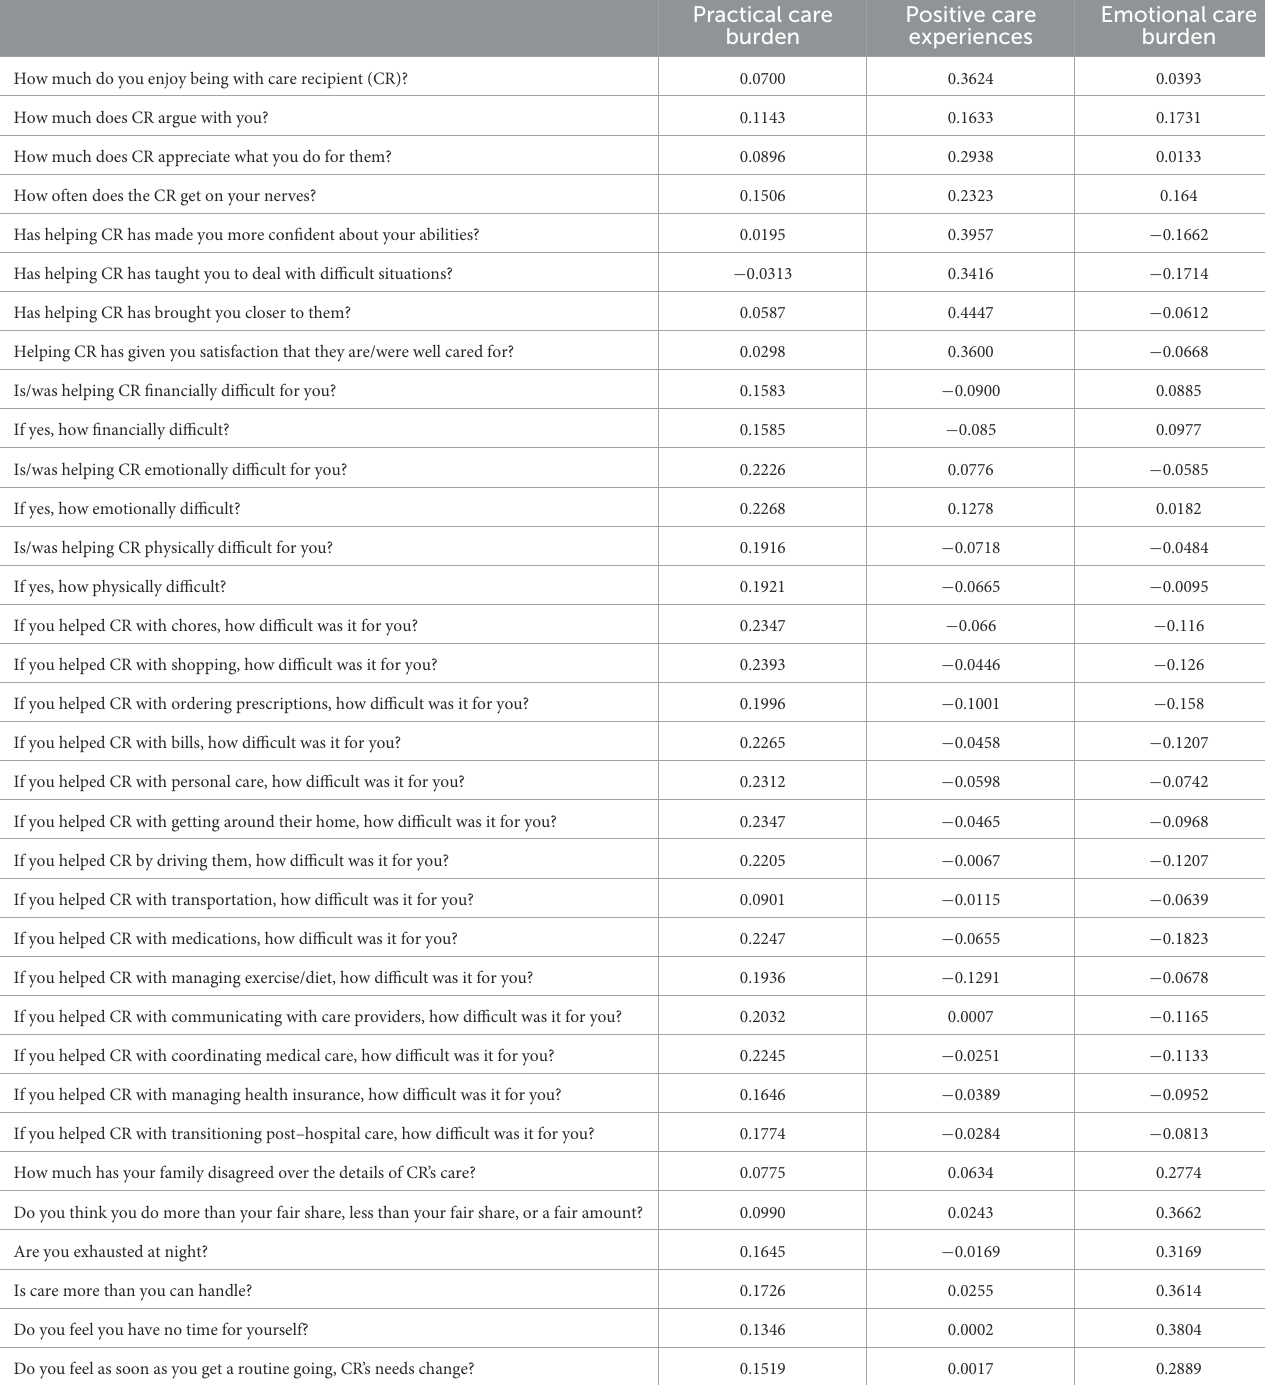
TABLE 1 Caregiver experience questions with principal component analysis factor loadings.